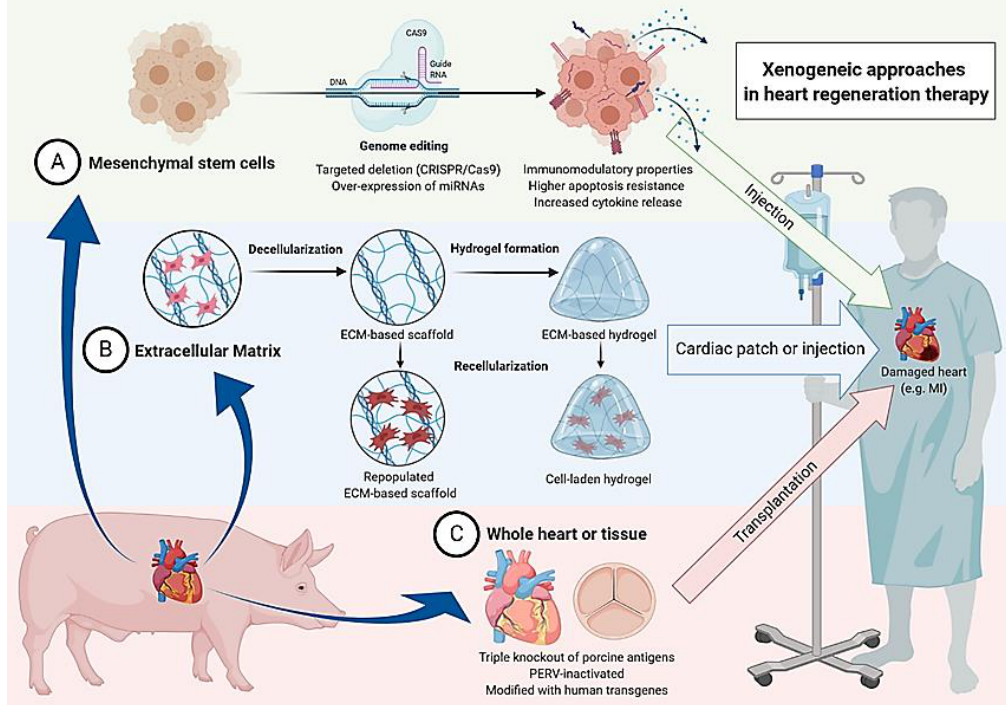
Figure 1. Summary of three conceivable xenogeneic approaches in heart regeneration therapy. Generally possible applications utilizing the pig as a donor include ( A ) transplantation of mesenchymal stem cells, ( B ) insertion of acellular or populated extracellular matrix, and ( C ) transplantation of the whole heart or heart valves of genetically engineered